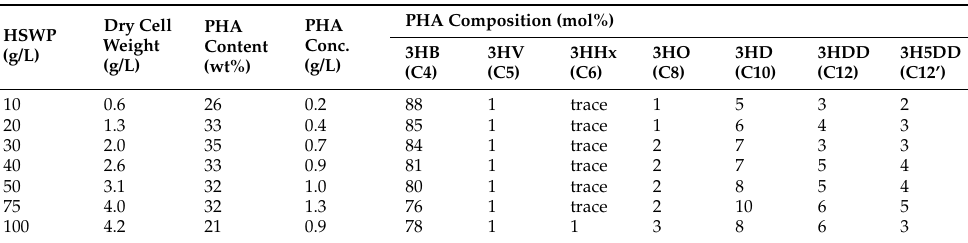
Table 3. Biosynthesis of PHA in Pseudomonas sp. 61-3 ( phbC :: tet ) harboring pJKSc54- phab from HSWP (by 0.6 N H 2 SO 4 ).